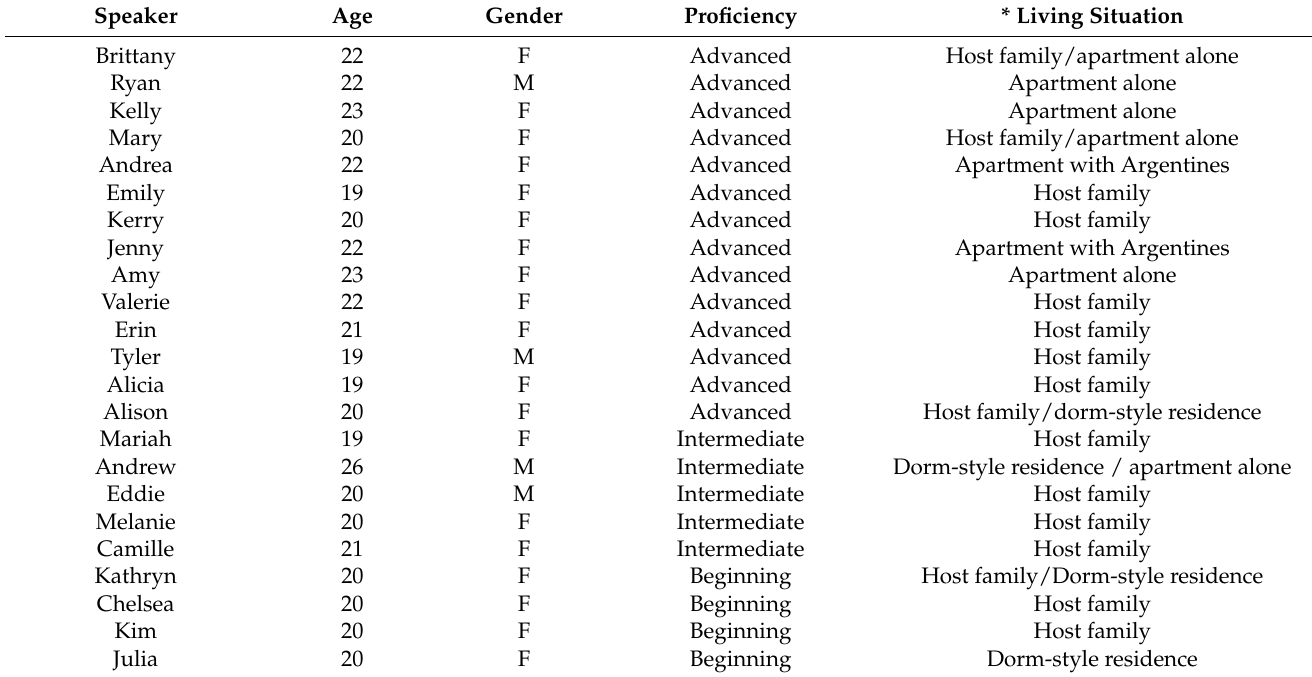
Table 1. Participant